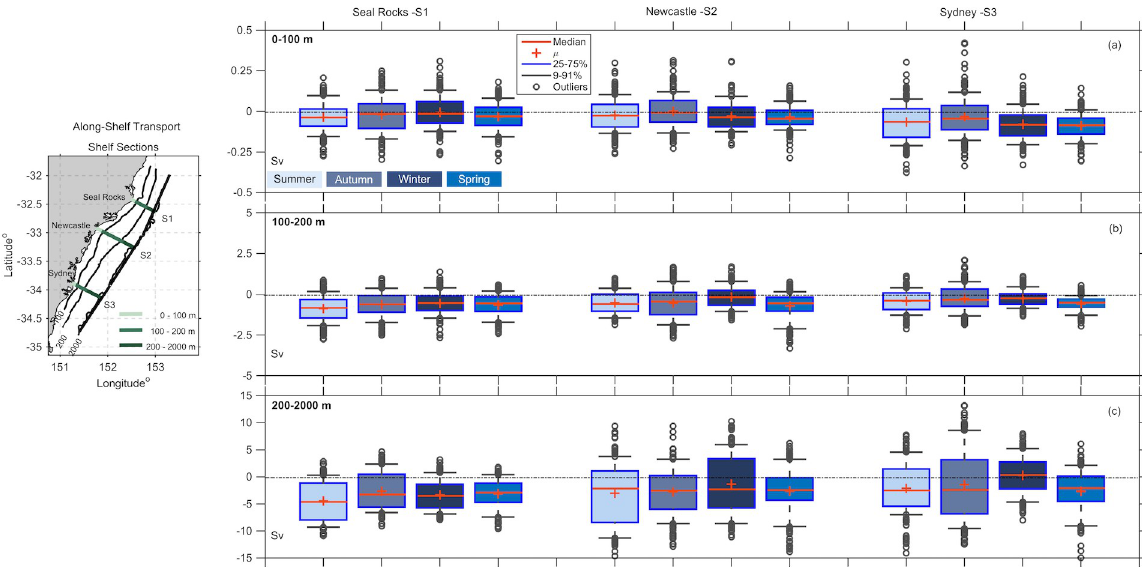
Fig 8. Box plots showing the along-shelf transport estimates (Sv) through three sections; Seal Rocks (S1), Newcastle (S2) and Sydney (S3), as shown in the map inset. The transports are shown across three segments a) the inner-shelf (0–100 m isobath) b) mid-shelf (0–200 m isobath), and c) across the outer shelf (200–2000 m isobath) coloured by season. Note the different scales for a, b, and c. As per the legend, the box plots show the median and the mean in red, the box shows the 25th to 75th percentiles, the tails show the 9th and 91st percentile, and the outliers are shown as circles.